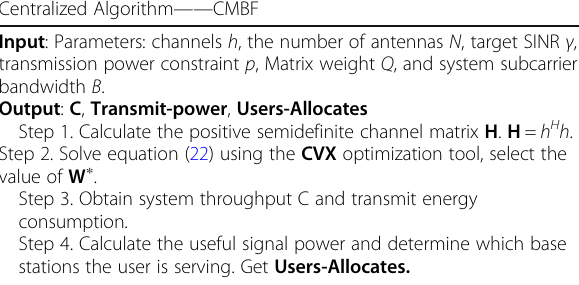
Centralized Algorithm —— CMBF